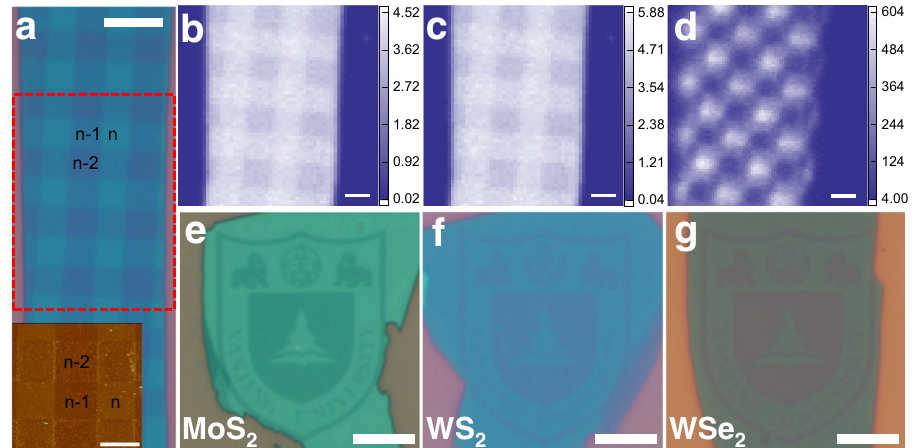
Fig. 3 Fabricating complex patterns on different TMDCs. a A checkerboard-like motif on MoS 2 de fi ned with two stripy etching cycles along the vertical and horizontal directions. Scale bar: 6 μ m. Inset: the AFM image scanned from a local area of the checkerboard-like motif. The label n , n − 1, and n − 2 represent the numbers of local MoS 2 areas. Scale bar, 3 μ m. b – d Raman and SHG mapping for the local area denoted by the red dashed rectangle in ( a ). Raman mappings were acquired by calculating the area ratio of the b E 1 and c A 1g modes of MoS 2 to the 520 cm − 1 mode of Si. The bright and blue 2g areas in the SHG mapping in panel d denote the local areas with odd and even numbers of MoS 2 layers. Scale bars in b – d , 3 μ m. e – g The patterned logos for Nanjing University on exfoliated MoS 2 , WS 2 , and WSe 2 , respectively. Scale bars, 6 μ m.